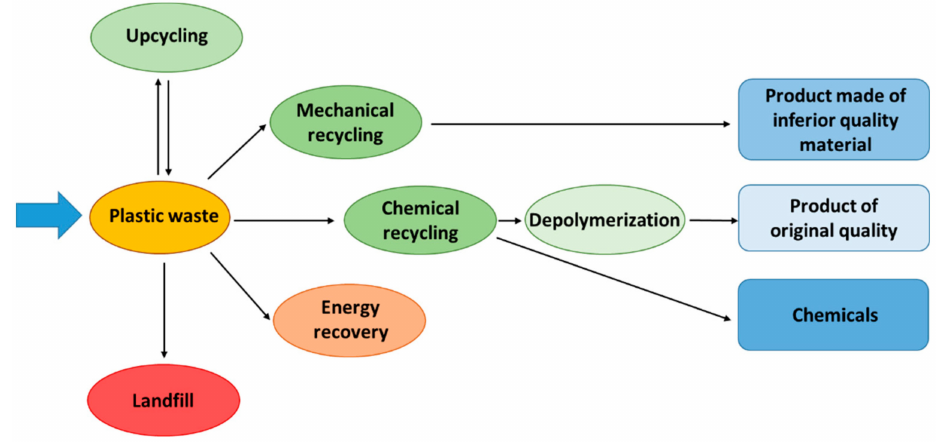
Figure 1. The plastic waste management recycling